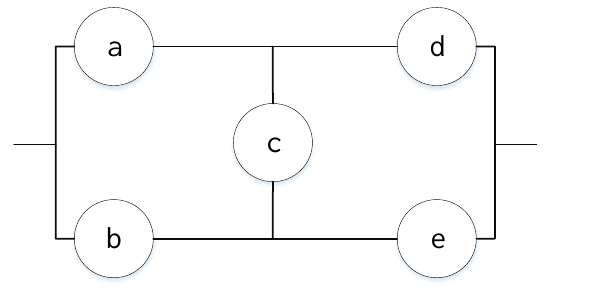
Figure 1. Bridge network.